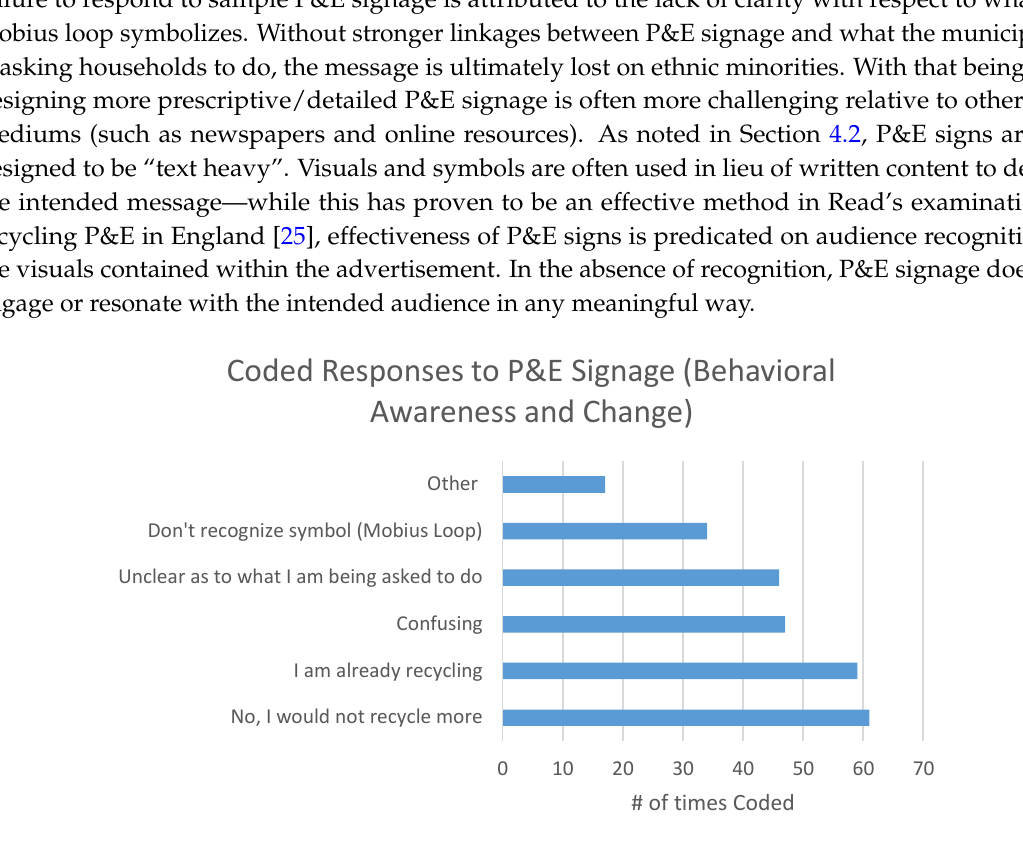
Figure 13. Coded Responses to P&E Signage